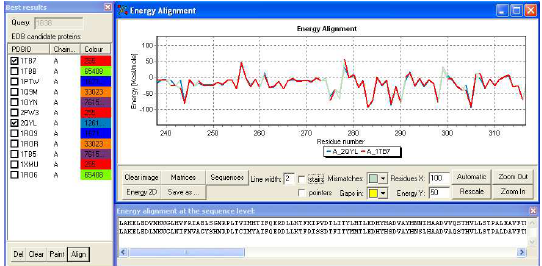
Fig. 13. Alignment of protein structures visible at the level of chosen component energy characteristics and the level of protein amino acid sequences.